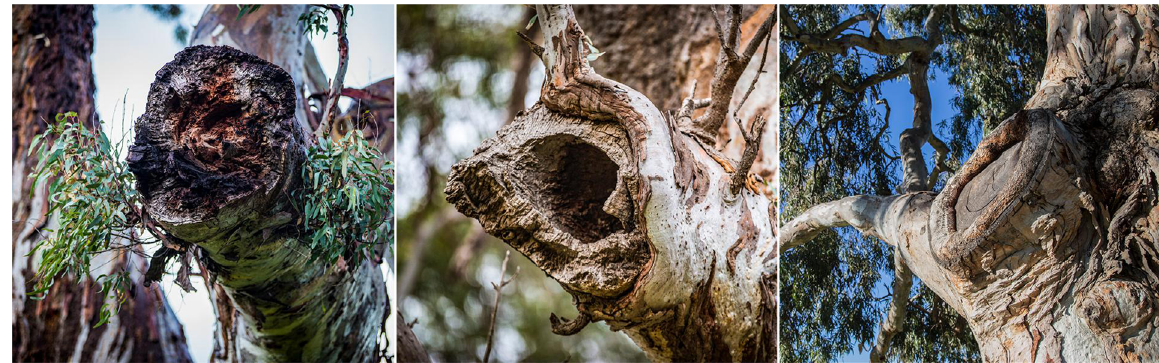
Fig. 4 A tree hollow ’ s life history. Alternative histories of broken branches of river red gums. Left: initial state, a decaying branch. Middle: outcome one, after fungal and animal modification. Right: outcome two, with human modification (Source: the